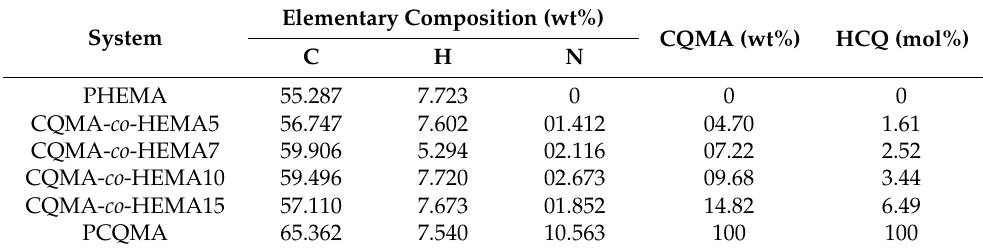
Table 4. Composition of CQMA- co -HEMA determined by CHN elementary